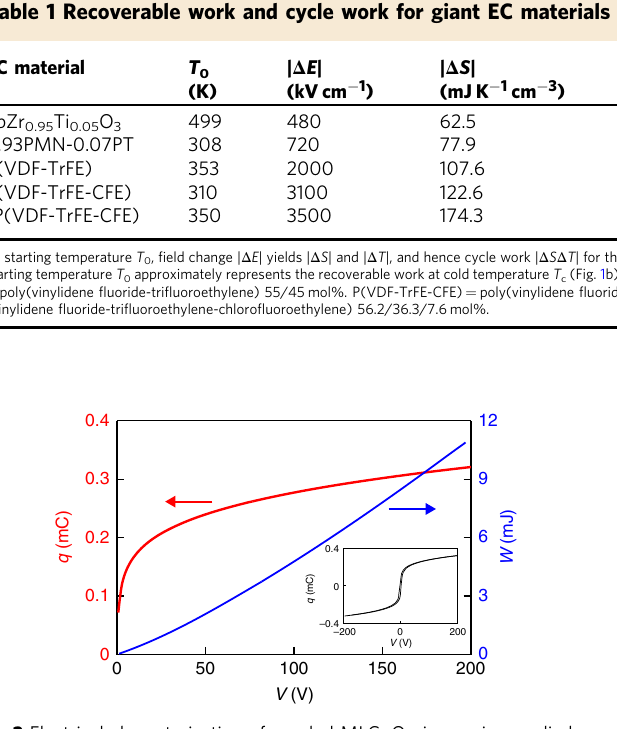
Fig. 2 Electrical characterization of a poled MLC. On increasing applied voltage V over 0.25 s to ensure adiabatic conditions (see Methods), charge q was reversibly increased from its remanent value of ~0.1 mC by doing work W , such that an equivalent amount of electrical energy E was stored in the capacitor. Inset: the corresponding major loop measured over 1 s